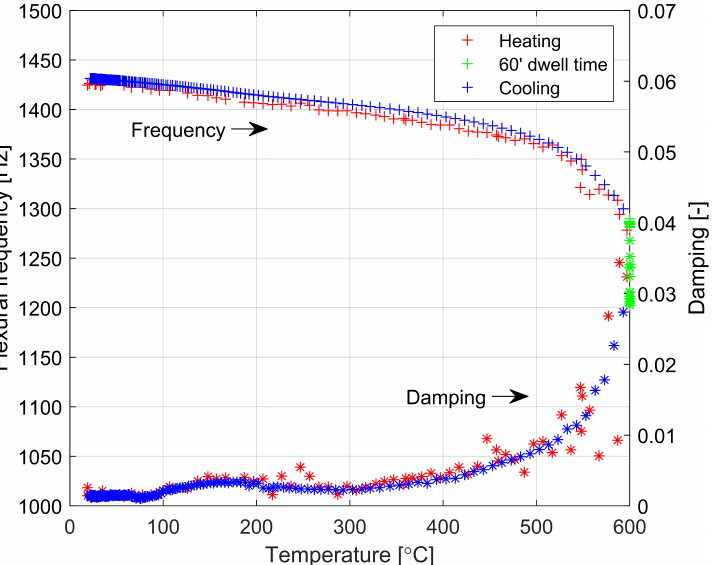
Figure 7. Dependencies of flexural frequency and damping versus temperature during the heating and cooling of soda lime glass with 60 min of dwell time at 873 K.